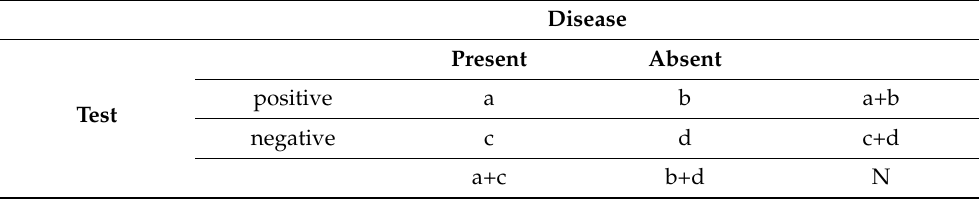
Table A1. Definitions and calculation details about the evaluation of tests